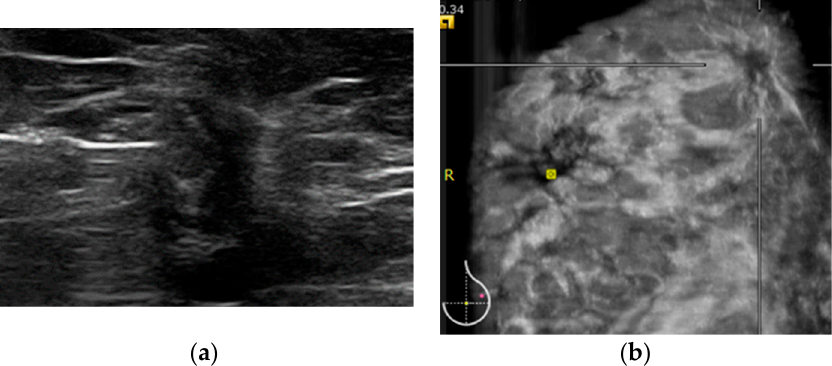
Figure 2. 51-year-old woman comes to our institute for routine screening. We reported cancer (invasive lobular carcinoma) identified by both HHUS and ABVS. ( a ) HHUS shows an architectural distortion at the upper-outer quadrant of the left breast. Images ( b ) show the retraction phenomenon in ABVS coronal view.